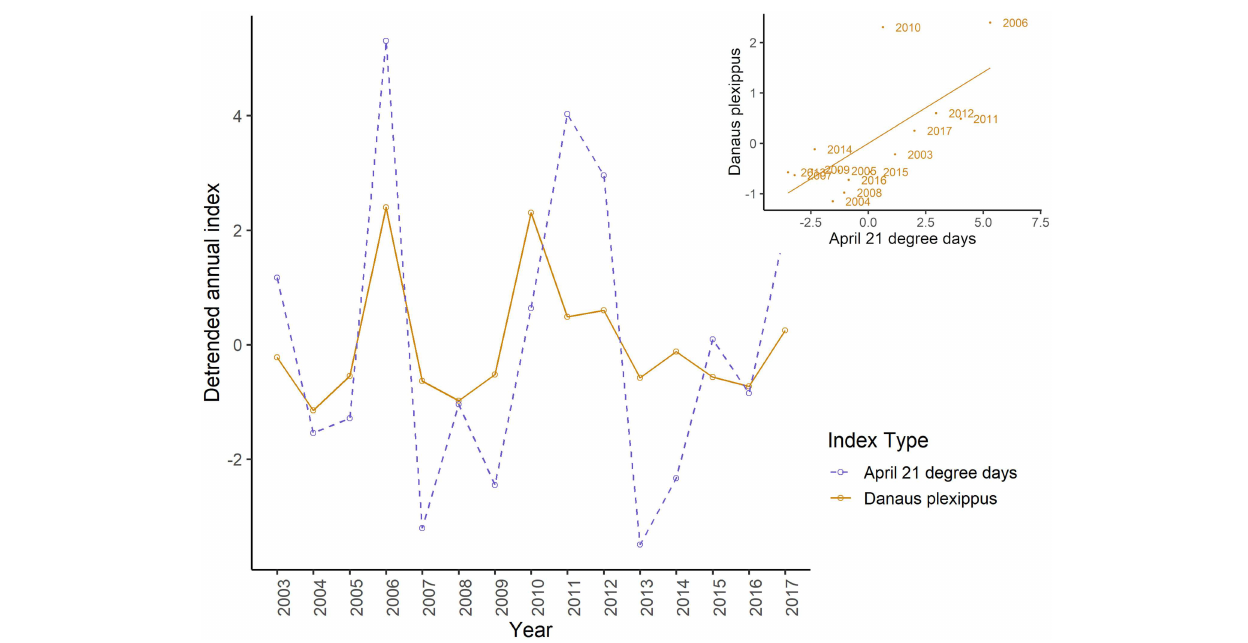
FIGURE 6 | Detrended annual indices for breeding monarch butterflies and detrended mean number of 21 ◦ days in April in the lower United States, by year and, inset, showing linear relationship between detrended monarch and detrended mean April 21 ◦ day indices. A significant Spearman correlation of 0.71 ( p = 0.01) was detected.